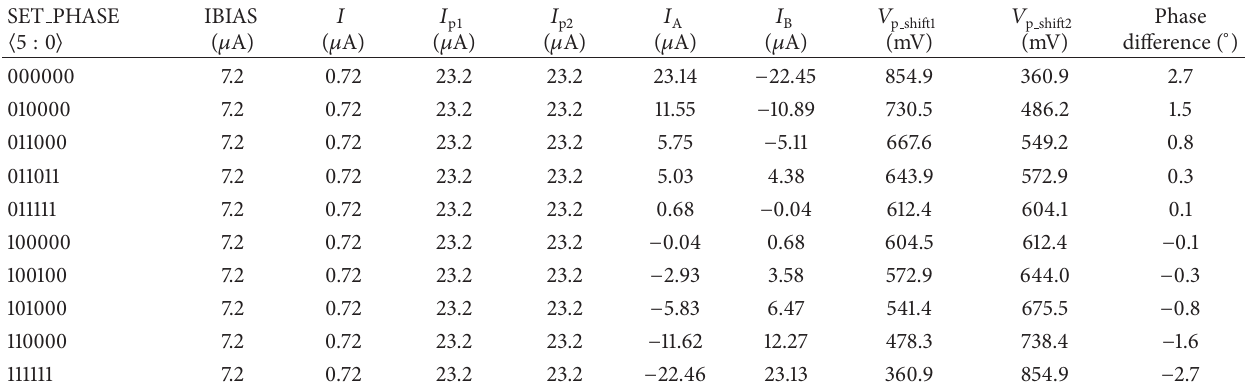
Table 3: Parameter settings and results of the